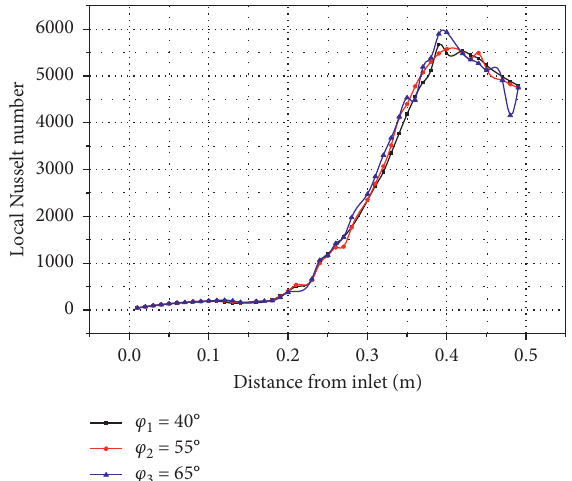
Figure 10: Axial velocity profiles near the exit of channel at x � 0.525m for different values of inclination angles: φ 1 � 40 ° ; φ 2 � 55 ° ; φ 3 � 65 ° .